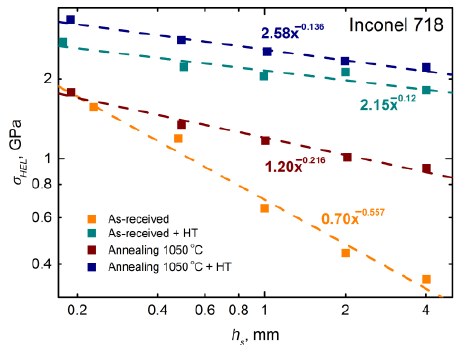
Figure 5. The effect of heat treatment on the Hugoniot elastic limit and the decay process of the elastic precursor in Inconel 718 superalloy samples.